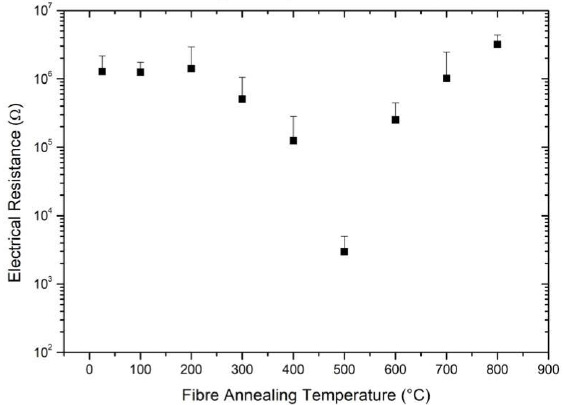
Figure 3. A semi-log plot of CNT fiber average electrical resistance as a function of annealing tem- perature in the nanoprobe. Electrical resistance drops to a minimum point followed by an irreversi- ble increase.